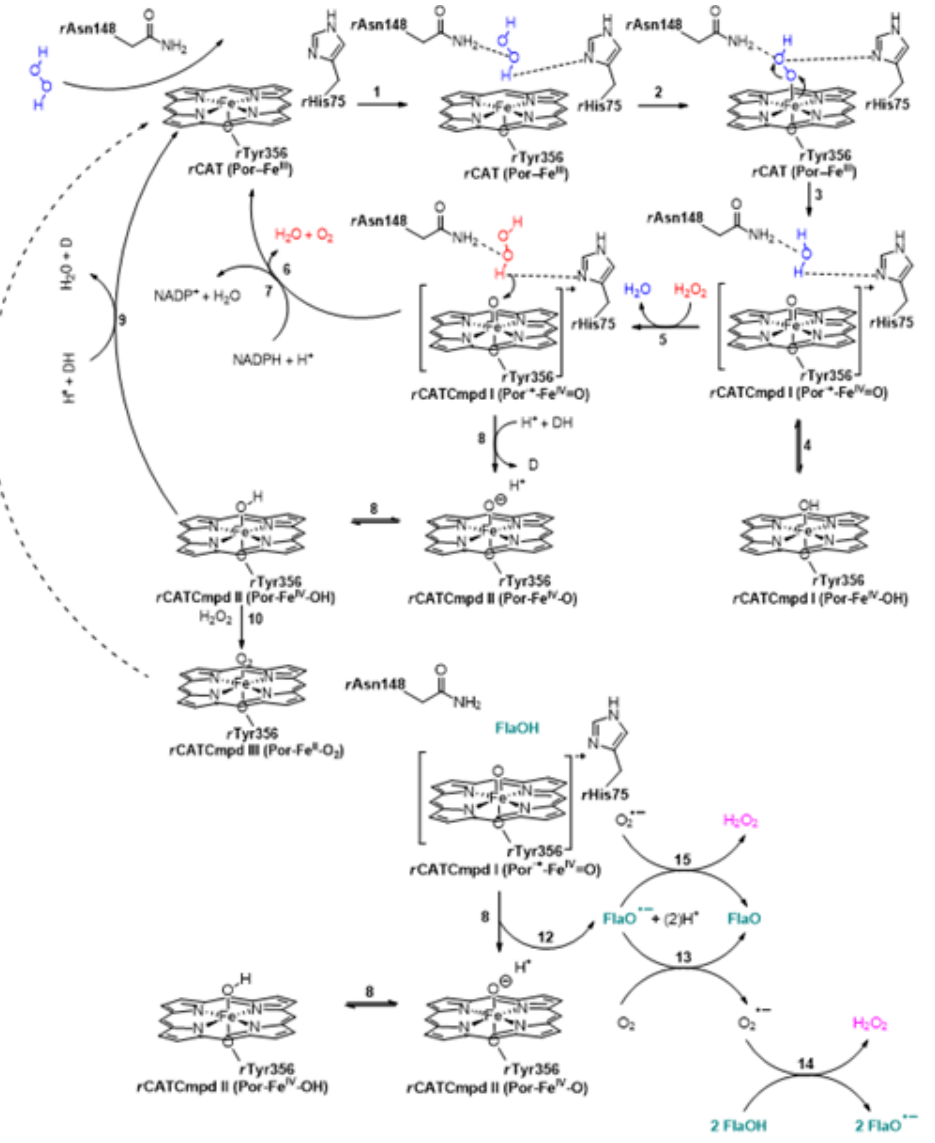
Scheme 2. The mechanisms of r CAT interconversion into the r CATCmpd I and r CATCmpd II; the first r H 2 O 2 entering the cascade is colored in blue, and the second one is depicted in red. The flavonoids (FlaOHs, labeled in dark green) induce a higher amount of r H 2 O 2 in liver cells; the new concentrations of r H 2 O 2 are depicted in